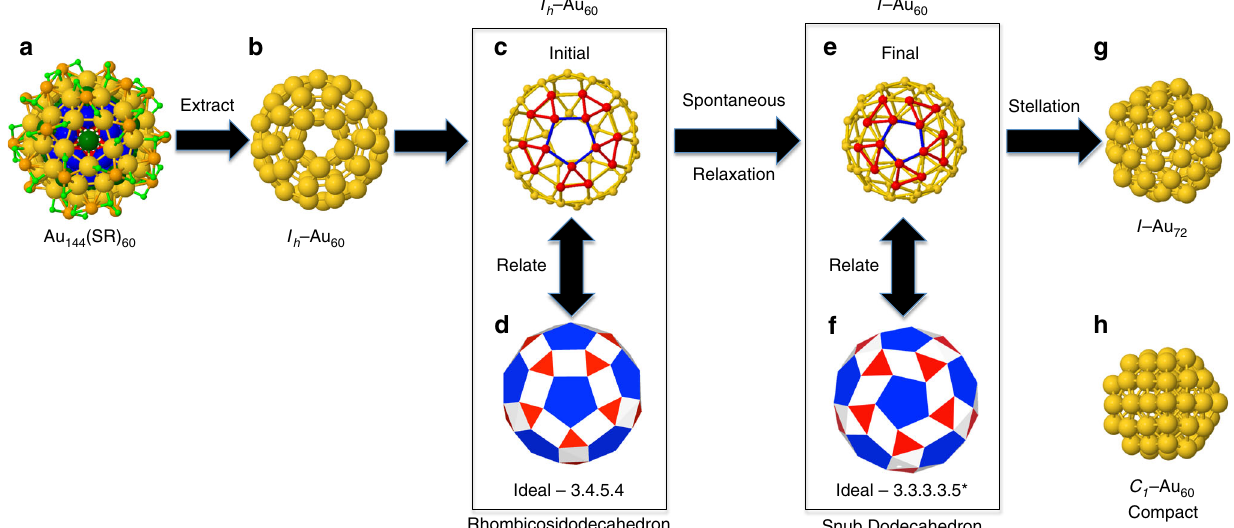
Fig. 1 Spontaneous formation of the I − Au 60 shell. a Atomic structure of Au 144 (SR) 60 from reference 13 , b the I h − Au 60 constitutive shell derived from Au 144 (SR) 60 , c and e show the ball-and-stick atomic models of the Au 60 shell before ( I h − Au 60 ) and after ( I − Au 60 ) atomic relaxation. Some Au atoms located in two opposite pentagonal facets are displayed in different colors to show the structural transition. Note the signi fi cant contraction of the 60-atom Au shell. d Rhombicosidodecahedron and f Snub dodecahedron Archimedean polyhedra, g the I − Au 72 nanoshell, and h compact C 1 − Au 60 nanoparticle